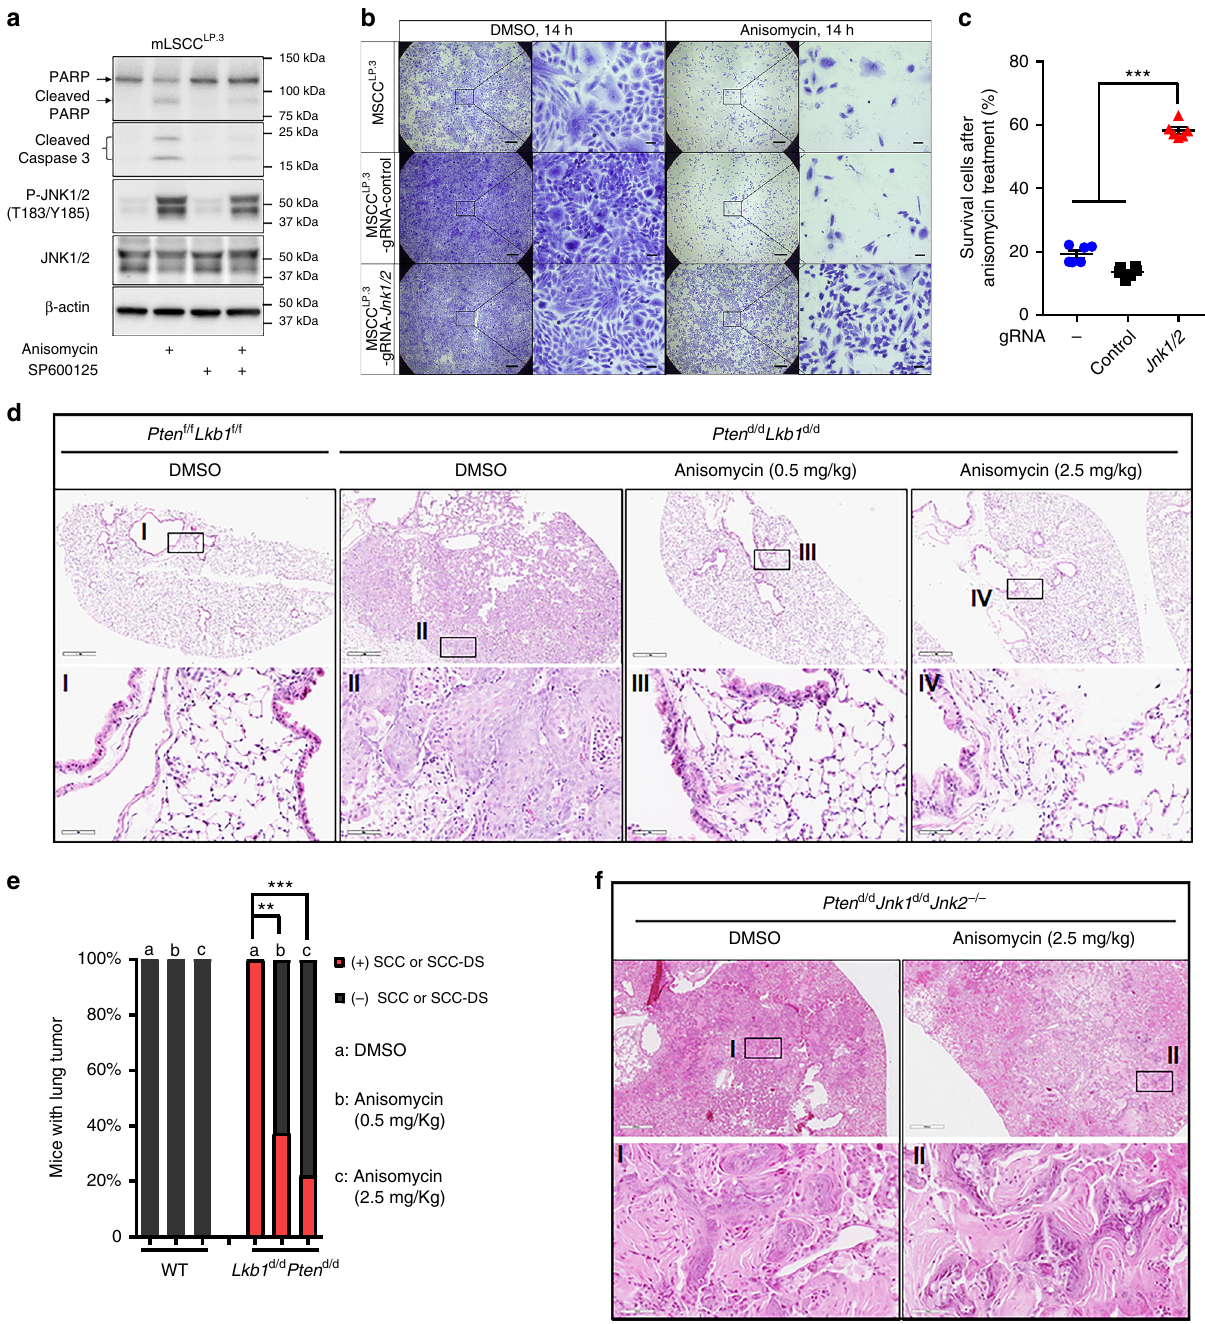
Fig. 5 Pharmaceutical activation of JNK1/2 attenuates LSCC development. a WB analysis of protein levels in mLSCC LP.3 cells with the treatment of Anisomycin (10 μ M, 5 h) and SP600125 (10 μ M, 4.5 h). b Representative crystal staining of survival mLSCC LP.3 parental cells and stable cells with lentiviral Cas9/gRNA targeting Control or Jnk1/2 after treatment with Anisomycin or DMSO. Scale bar: 500 μ m (large area) and 50 μ m (small area). c Quanti fi cation of cell survival assay of survival mLSCC LP.3 parental cells and stable cells with lentiviral Cas9/gRNA targeting Control or Jnk1/2 was performed. Error bar is SEM; ANOVA-TKMC Test: *** P < 0.001. d Representative H&E staining of lungs or lung tumors of the mice treated with DMSO or Anisomycin. e Quanti fi cation of mice with lung SCC or SCC-DS at the endpoint of treatment (Fig. 5d). The b group of Lkb1 d/d Pten d/d had eight mice and the remainder of each group included nine mice. χ 2 test (two-way): ** P < 0.01; *** P < 0.001. f Representative H&E staining of lungs or lung tumors of the mice treated with DMSO ( n = 9) or Anisomycin ( n =